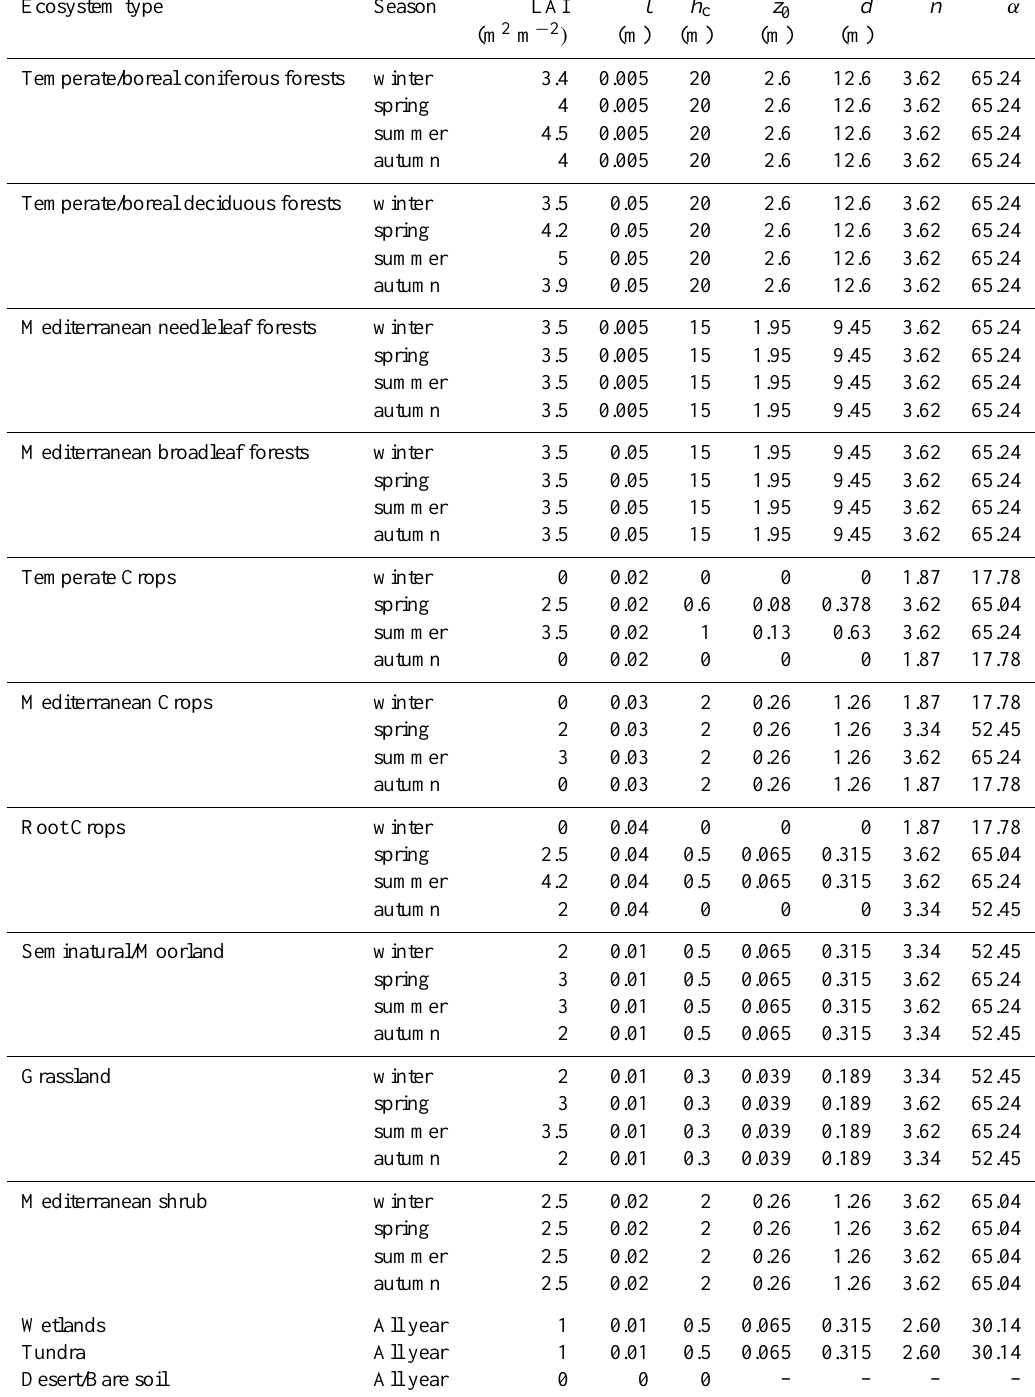
Table 6. Parameters used for the calculation of aerodynamic and boundary layer resistances above ( R a and R b ) and within canopy ( R ac ) ,